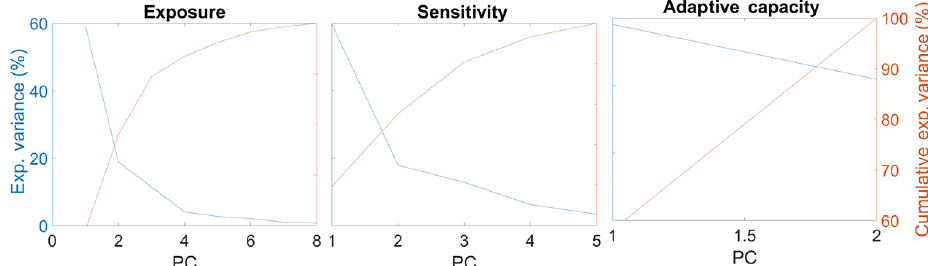
Figure 4. Explained variance and cumulative explained variance by each of the PCs of each component: exposure, sensitivity and adaptive capacity.